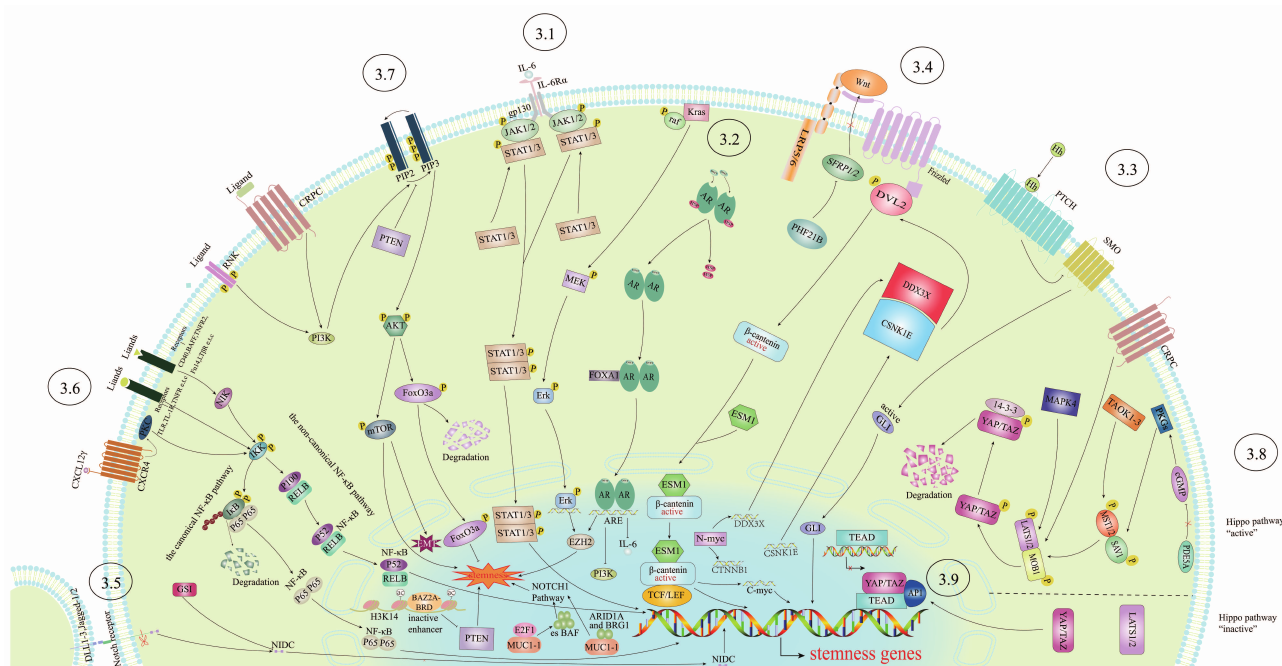
Figure 2. A schematic depiction of signaling pathways involved in PCSC